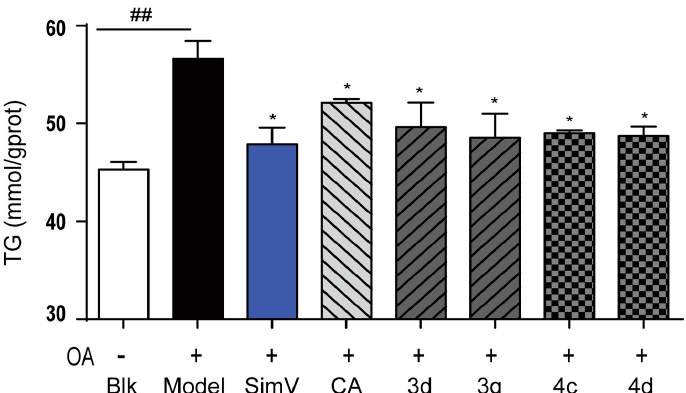
Figure 4. Inhibitory effects of compounds toward triglycerides in HepG2 liver cells. Positive control: simvastatin (SimV, 47.89%) and chlorogenic acid (CA, 51.51%); blank (Blk, 45.30%): DMEM; OA (56.61%): oleic acid. Intracellular levels of triglycerides were measured by kits according to the manufacturer’s instructions. Bars depict the means ± SEM in triplicate. ## p < 0.01 versus blank group (Blk); * p < 0.05 versus OA-treated cells.